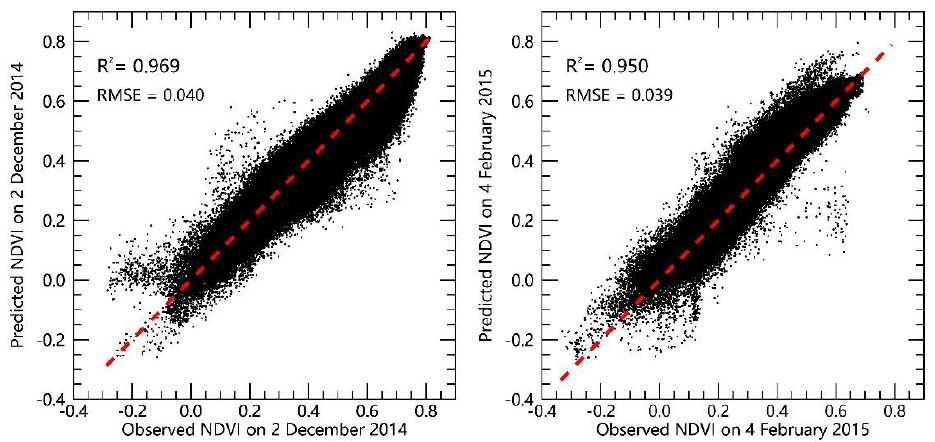
Figure 5. Scatter plot of observed and predicted NDVIs.